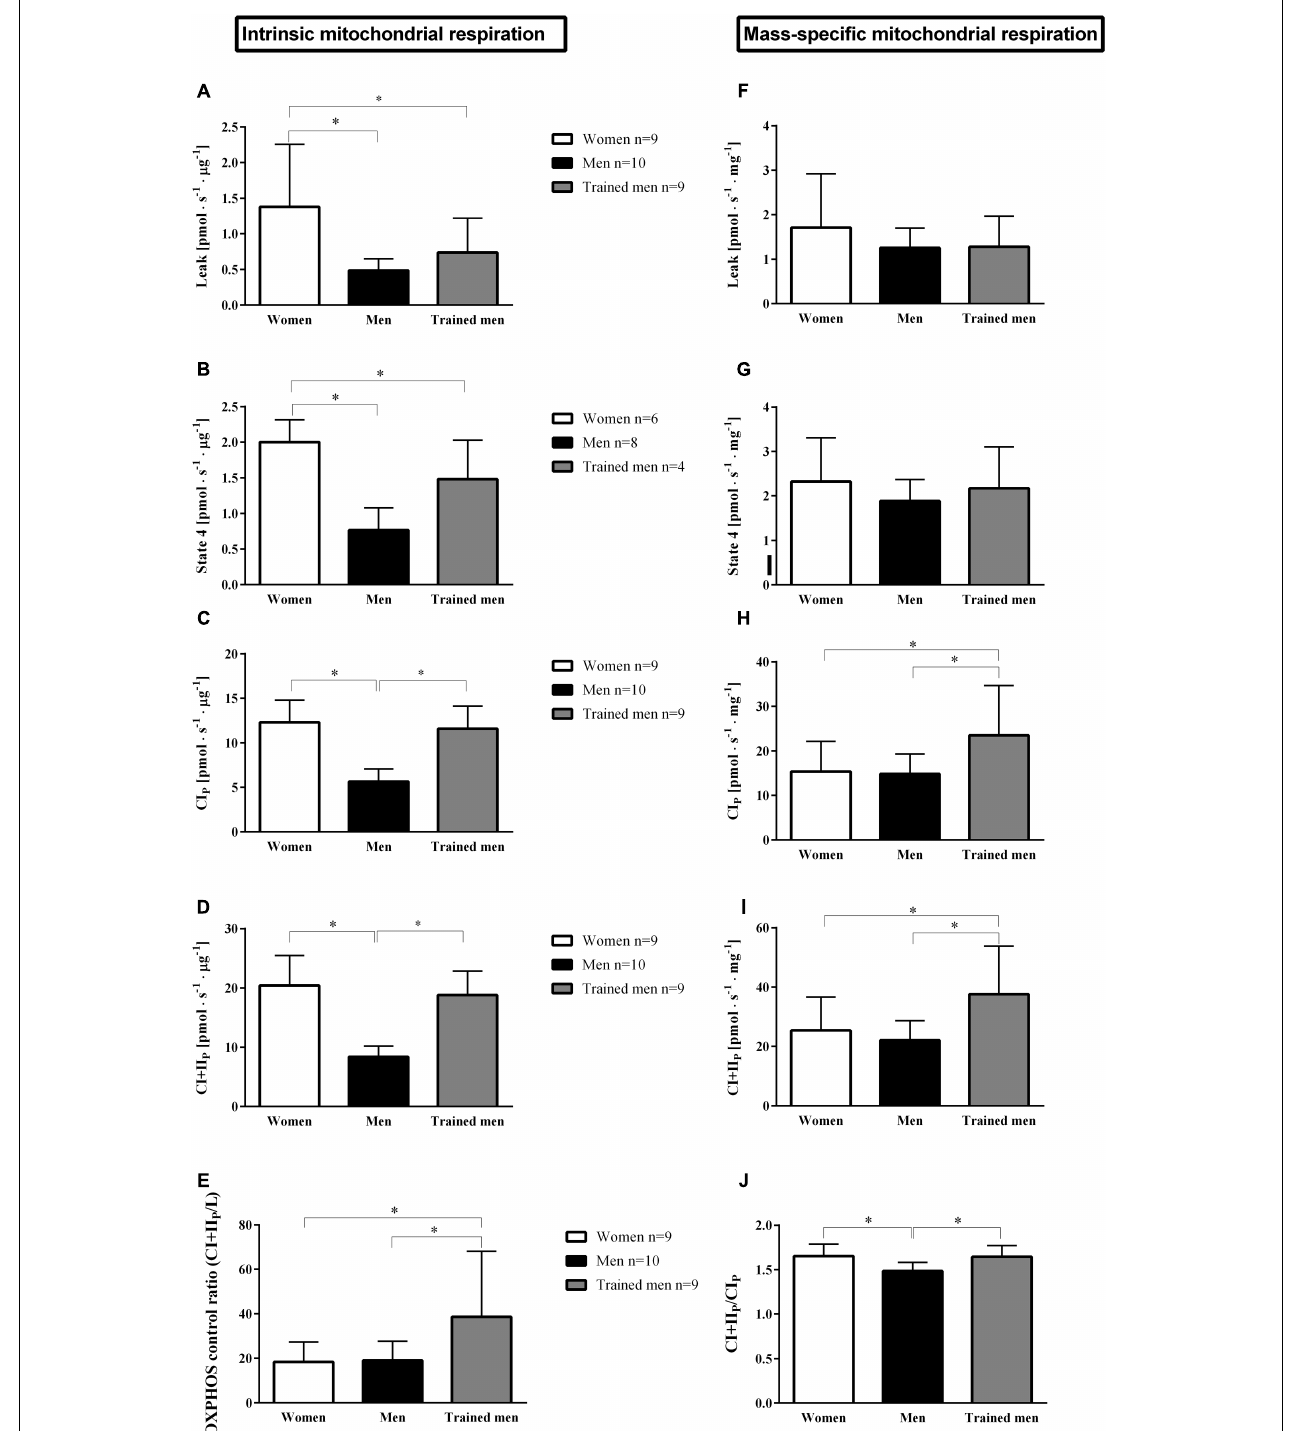
FIGURE 1 | Mean ± SD of mitochondrial respiration rates normalized by protein levels of mitochondrial suspension (pmol s − 1 µ g protein − 1 ; intrinsic mitochondrial oxidative respiration) and by the initial muscle wet weight (pmol s − 1 mg − 1 ; mass-specific mitochondrial respiration) in women, men, and trained men groups for: A , F , leak respiration is the respiratory rate in the presence of substrates without addition of adenylates; B , G , state 4 is the respiratory rate when ADP is phosphorylated maximally to ATP; C,H , complex I P is the maximum ADP stimulated respiration rate in the presence of complex I substrates; D,I , complex I+II P is similar to C,H but with added convergent electron flux through complex II by adding succinate (CI+II P ); E , maximal oxidative phosphorylation capacity (OXPHOS) control ratio (CI+II P /Leak) indicates the limitation of OXPHOS by the phosphorylation system; J , CI+II P /CI P indicates the contribution of CII respiration to maximal respiration. ∗ p < 0.05 between groups.